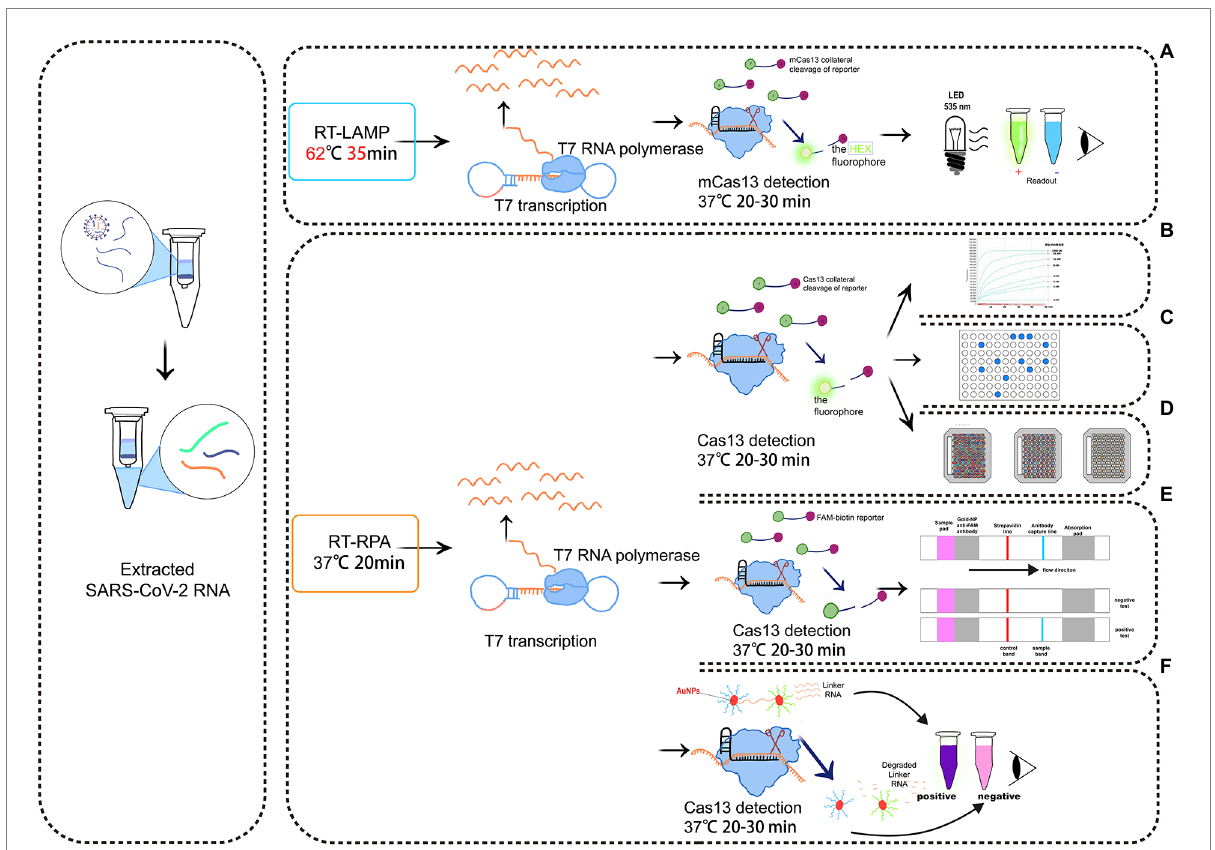
FIGURE 3 Schematic diagram of a detection system based on Cas13. (A) RT-LAMP with the mcas13 system; (B) the SHERLOCK system; (C) a system consisting of SHERLOCK and ddcas13a; (D) a carmen-cas13 (gene chip detection) system; (E) a system consisting of SHERLOCK and LFA; (F) a system utilizing both SHERLOCK and